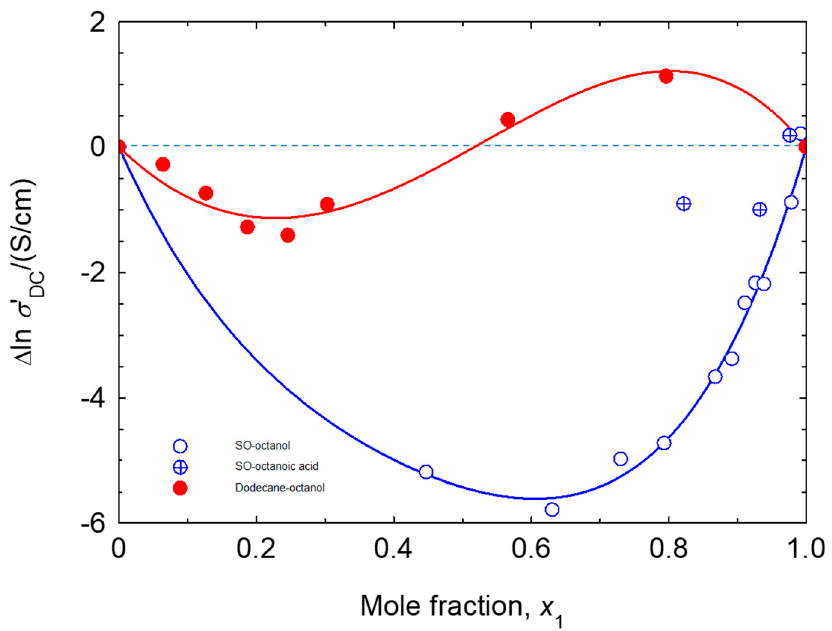
Figure 8. Excess logarithmic molar electrical conductivity plots for the binary mixtures as a function of the polar component mole fraction.